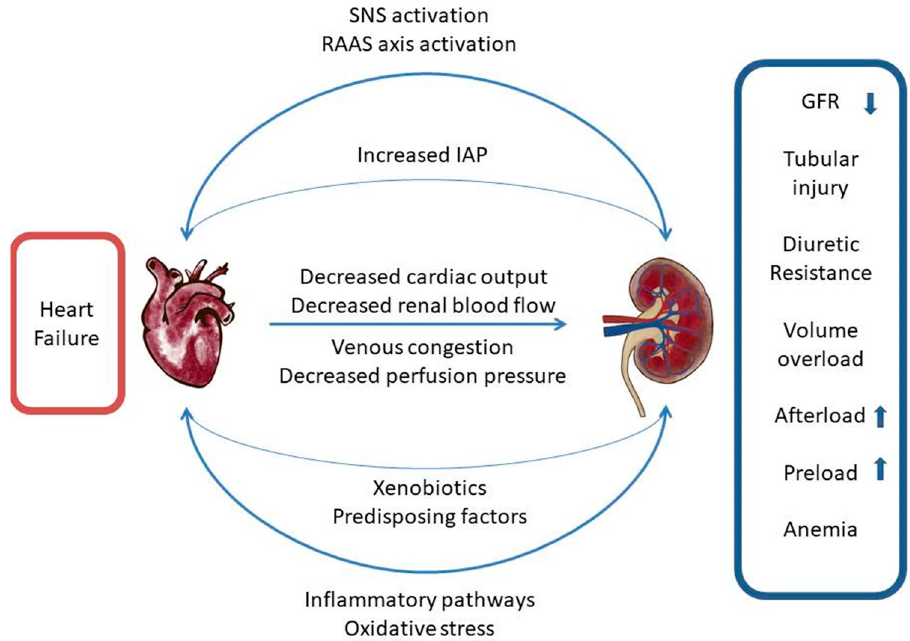
Figure 1. Cardiorenal network of interactions. SNS—sympathetic nervous system, RAAS—renin- angiotensin-aldosterone system, IAP—intraabdominal pressure, GFR—glomerular filtration rate.